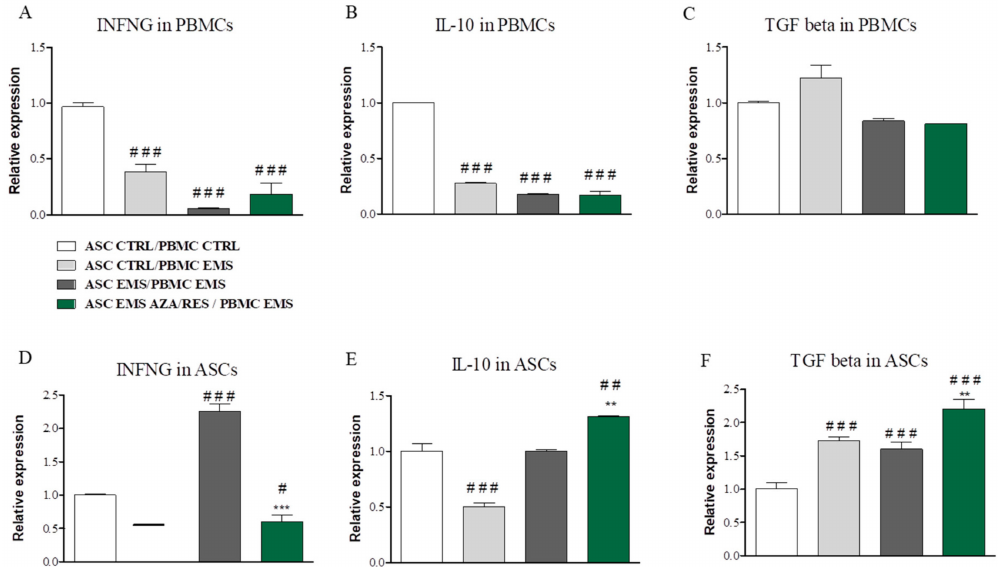
Figure 3. Gene expression profile in PBMCs and ASCs after co-culture. Using RT-PCR expression of INFNG ( A ), IL-10 ( B ), and tumor growth factor (TGF) beta ( C ) was examined in PBMCs after co-culture with ASCs. The mRNA levels of the same genes-INFNG ( D ), IL-10 ( E ), and TGF beta ( F ) was also investigated in ASCs. Statistical significance was labelled with hash (#) when comparing to control group (ASC CTRL /PMBM CTRL ) and asterisk (*) when comparing to the EMS group (ASC EMS /PBMC EMS ). Results expressed as mean ± S.D. #: p < 0.05; ##, ** p < 0.01; ###, *** p <